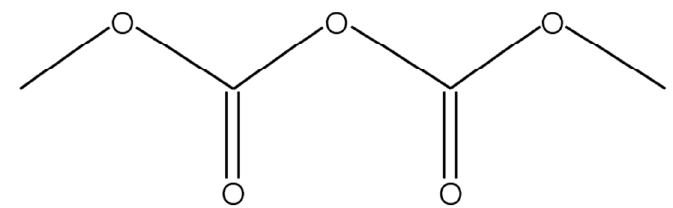
Figure 1. The structure of dimethyl dicarbonate.